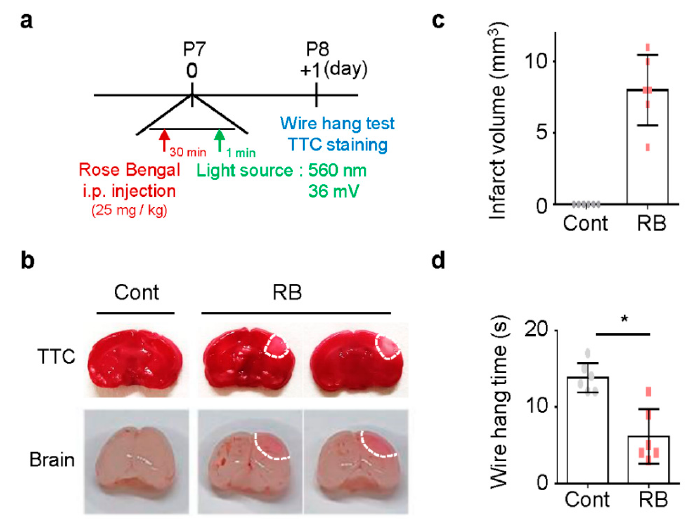
Figure 1. Damage following Rose Bengal (RB) photothrombosis in perinatal rat model. ( a ) Experimental design for animal model. Photothrombosis is achieved via intraperitoneal injection of RB (25 mg / kg) and illumination (532 nm, 36 mV) of the sensory-motor cortex through a cranial window. ( b ) Representative photographs of coronal brain sections stained with 2,3,5-TriphenylTertrazoium Chloride (TTC) and whole-brain at one day after modeling. The lack of formazan production (white tissue) indicates an infarct area with a white line. Quantification of ( c ) infarct volume and ( d ) wire hang test. Data represented as mean ± SD. * p < 0.01 compared with the control group.